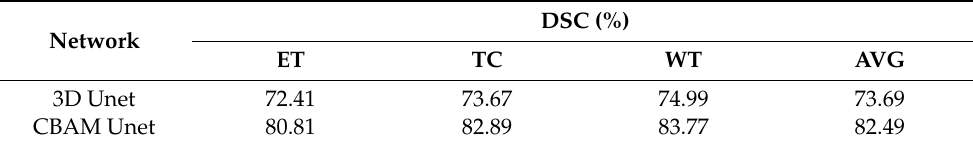
Table 4. Results of the DSC evaluation of the classical networks on the validation set. AVG is the abbreviation for average.